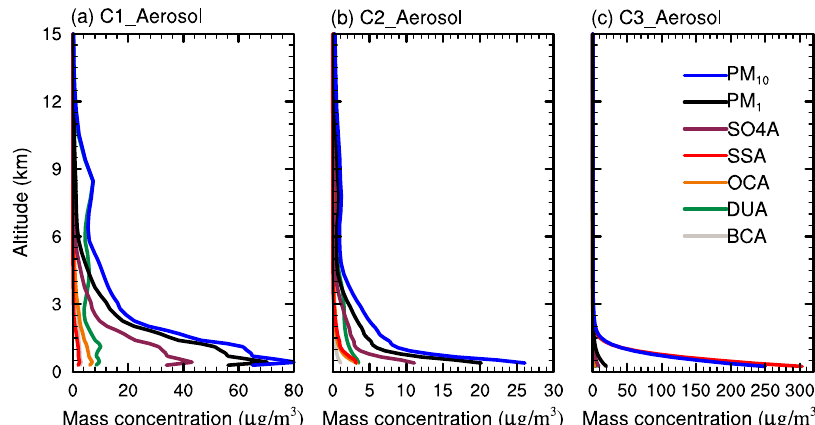
Fig. 1 Aerosol mass concentration pro fi le of cases. a Case1 (C1). b Case 2 (C2). c Case 3